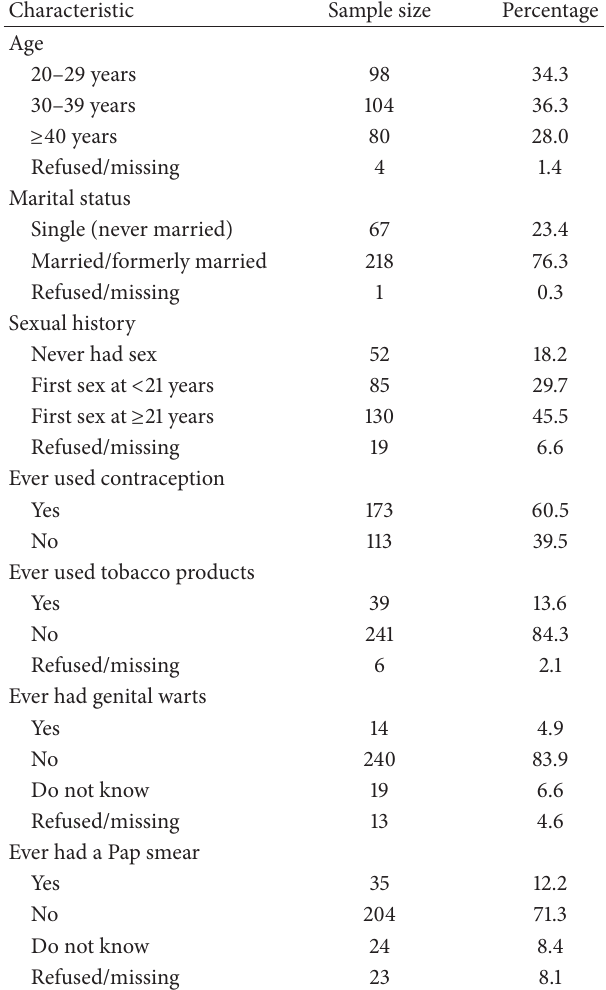
Table 1: Sample characteristics, Odisha, India ( 𝑛 = 286